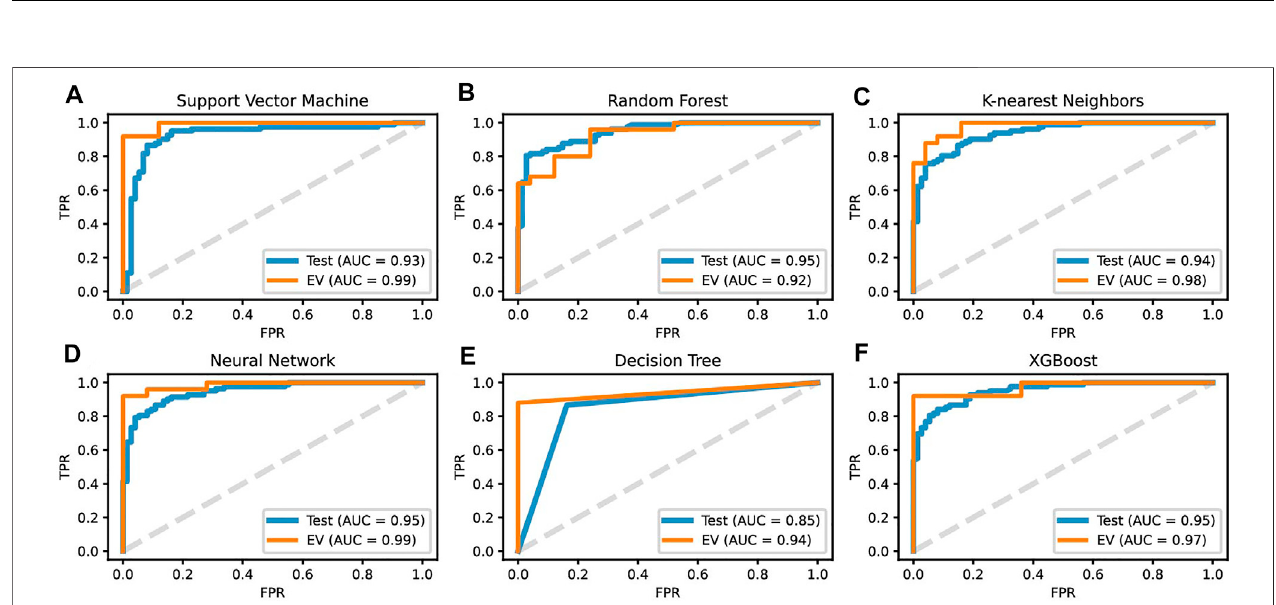
FIGURE7| ROCcurvesforthepredictedprobabilityonthetestandEVsetsofallsixmachinelearningdiagnosticmodels: (A) SVM, (B) RF, (C) KNN, (D) NN, (E) DT and (F) XGB.